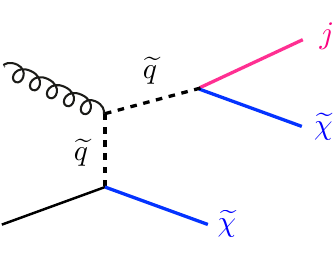
Figure 1 . A diagram for squark-electroweakino productions.